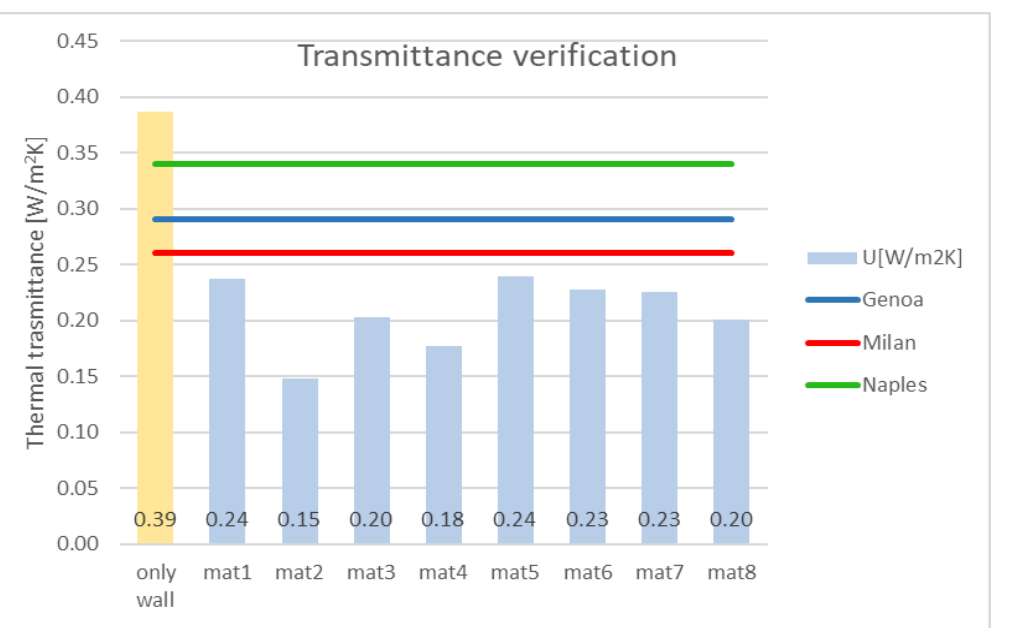
Figure 6. Thermal transmittance in brick walls with different heat reflective insulating layers. The red, blue, and green lines represent the threshold for different cities.